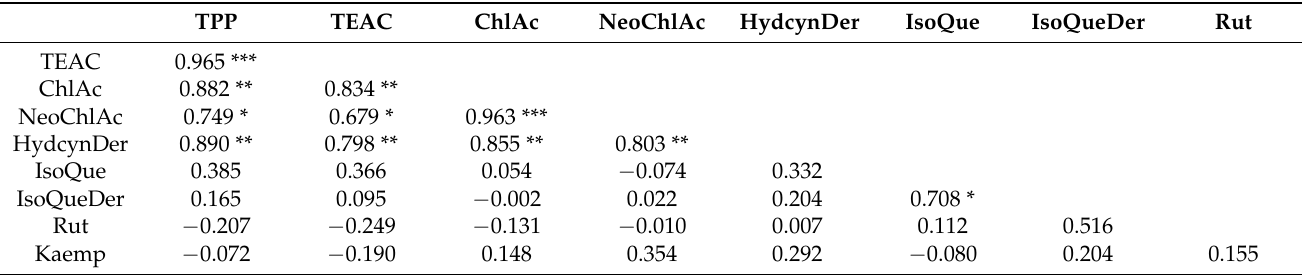
Table 5. Correlation matrix for quantified analytical parameters (TPP, TEAC, and selected quantified flavonoids: chlorogenic acid (ChlAc), neochlorogenic acid (NeoChlAc), hydroxycinnamic acids derivatives (HydcynDer), isoquercetin (IsoQue), isoquercetin derivatives (IsoQueDer), rutin (Rut), kaempferol